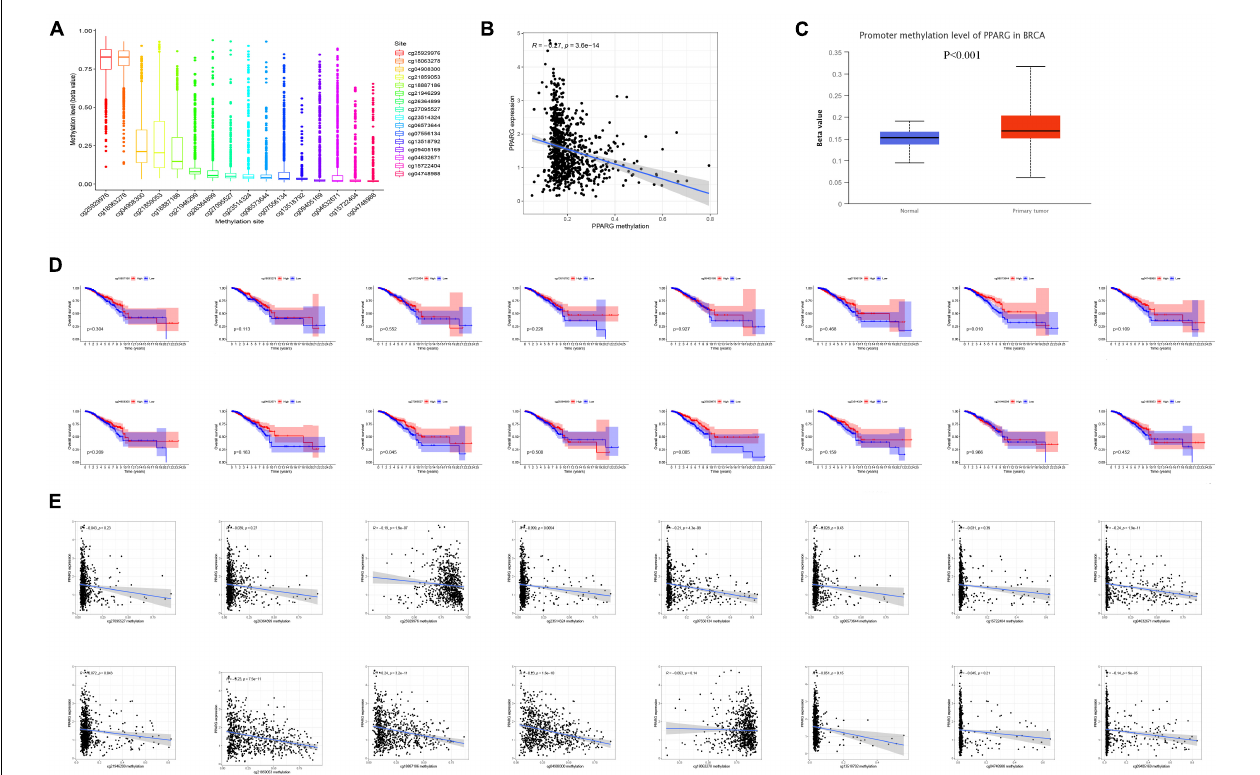
FIGURE 4 | DNA methylation analysis of PPARG in BRCA. (A) Boxplot of methylation sites. (B) Correlation between PPARG methylation level and mRNA expression level. (C) The methylation expression level of PPARG was accessed from UALCAN. (D) The correlation between the level of site methylation and the prognosis. (E) Correlation between site methylation level and mRNA expression